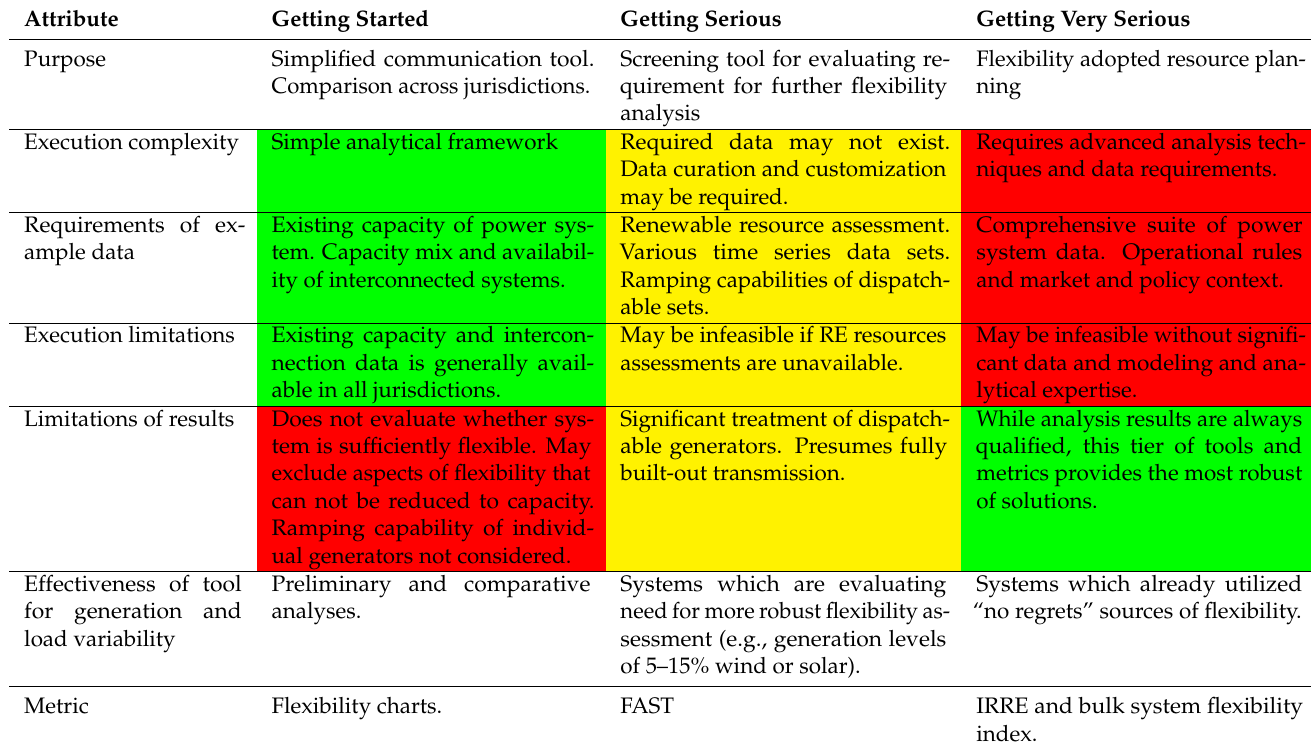
Table 10. Analytical framework to measure